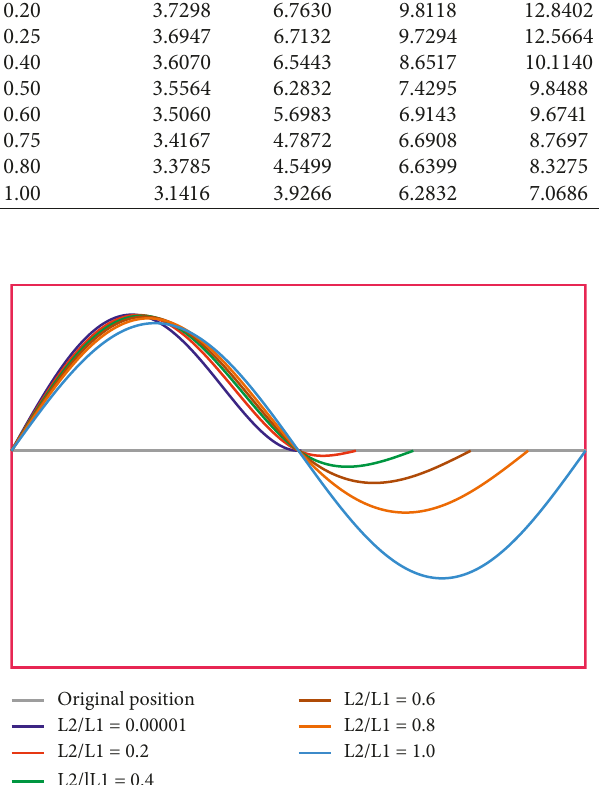
L L 2 / 1 with the